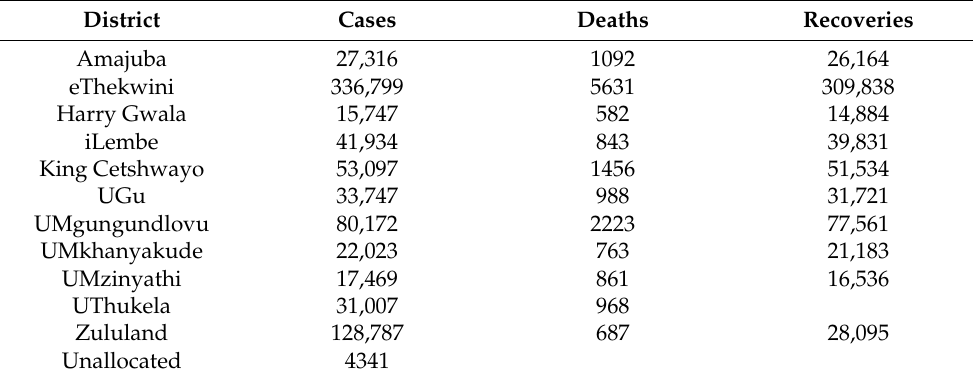
Table 2. COVID-19 Cases per District in KwaZulu-Natal. District Cases Deaths